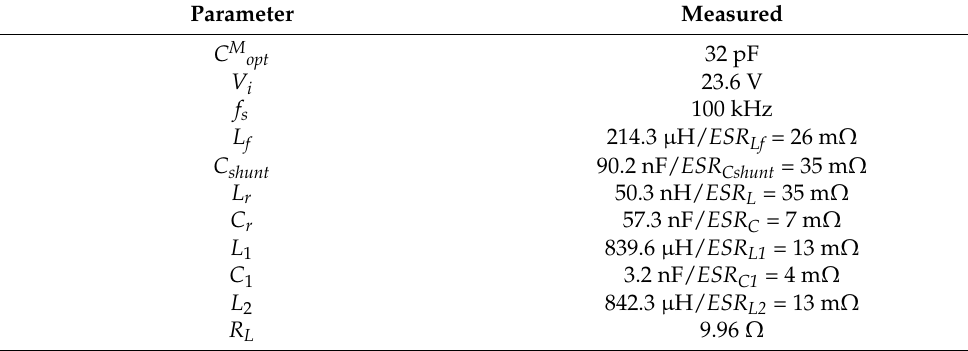
Figure 12. Experimental setup. ( a ) Board and instrumentations. ( b ) Experimental board. ( c ) Electrical schematic. Table 2. Experimentally measured values of components and their parasitics.